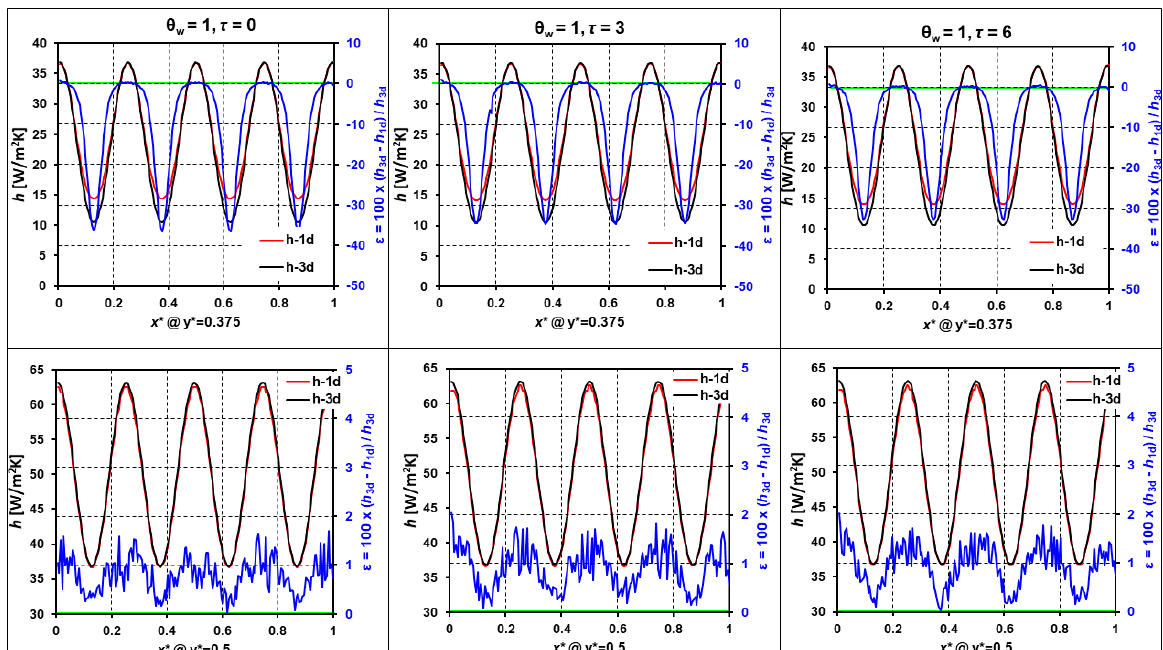
Figure 5. Method A, Case II: Local h variation with x* at y* = 0.375 and y* = 0.5 (see Figure 1) and their relative % differences.